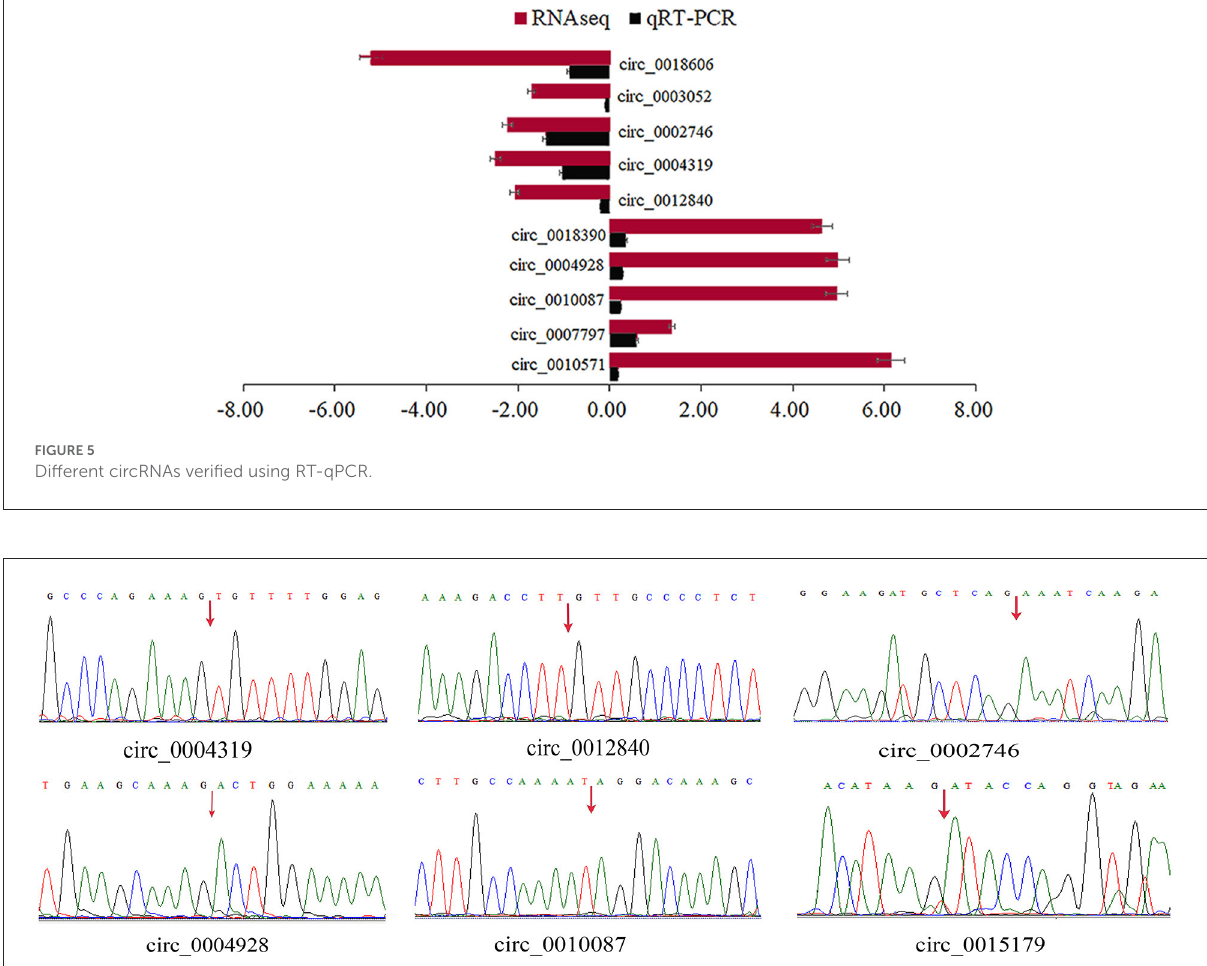
FIGURE6 Head-to-tail splice junctions for the circRNAs were confirmed by DNA sequencing and are marked with a red arrow on the DNA sequence chromatograms.